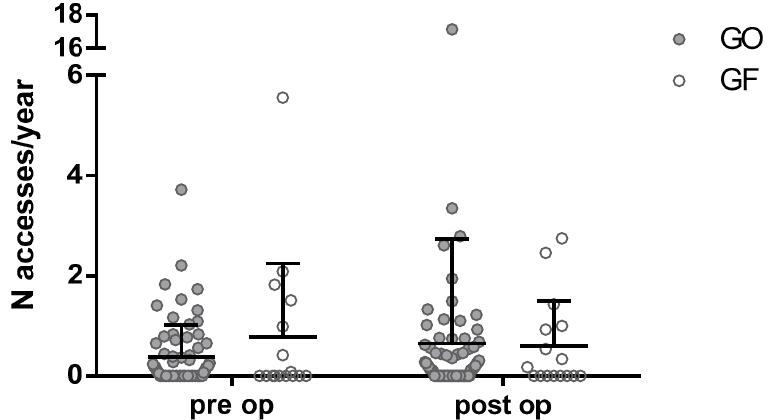
Figure 2. Number of Emergency Department admissions due to respiratory-related complica- tions/years pre-operatively and post-operatively comparing gastrostomy only placement (GO) and gastrostomy plus fundoplication (GF). Bars for median and upper quartile. p = 0.43, 2-way